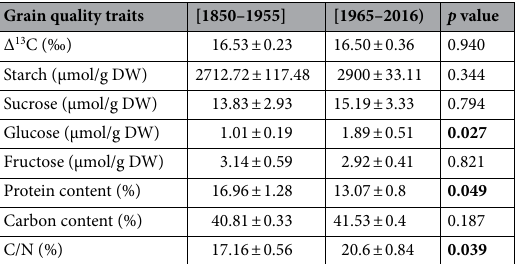
Table 3. Global averages of wheat grain quality traits in [1850–1955] and [1965–2016]. Mean ± standard error (SE) (n = 3–18). The calculation of p values is based on one-way ANOVA. Values in bold indicate statistical significance ( p <